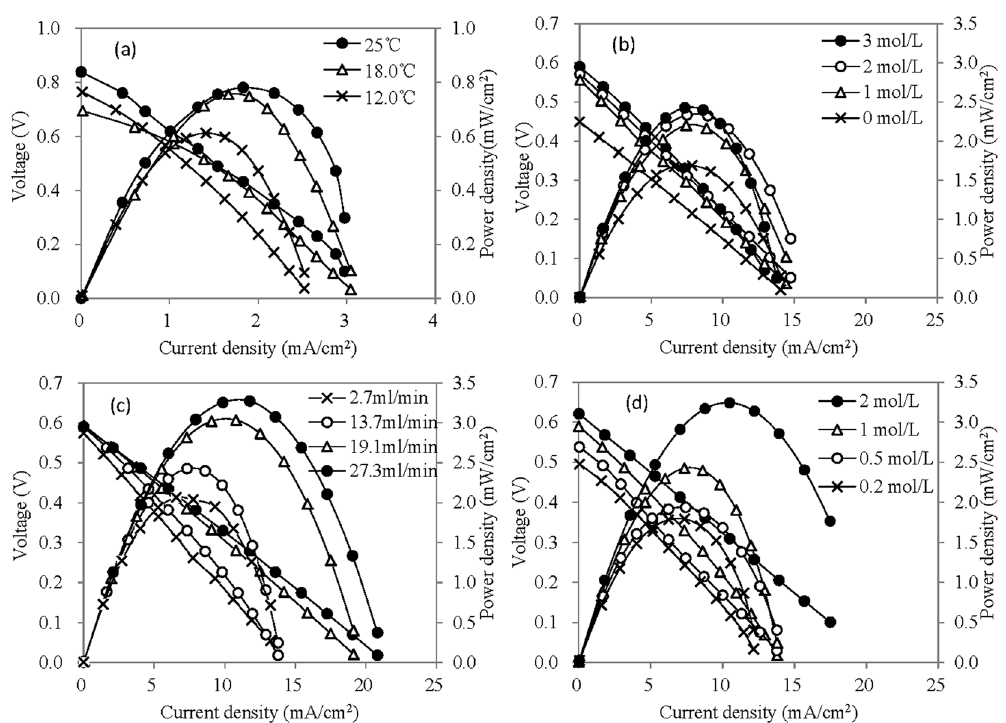
Figure 2. Performance of the LCFC under different operational conditions ( a ) using PW 12 as POM-I at different temperatures; ( b ) using PMo 12 as POM-I at different concentrations of phosphoric acid; ( c ) using PMo 12 as POM-I at different flow rates of anolyte; ( d ) using PMo 12 as POM-I at different initial glucose